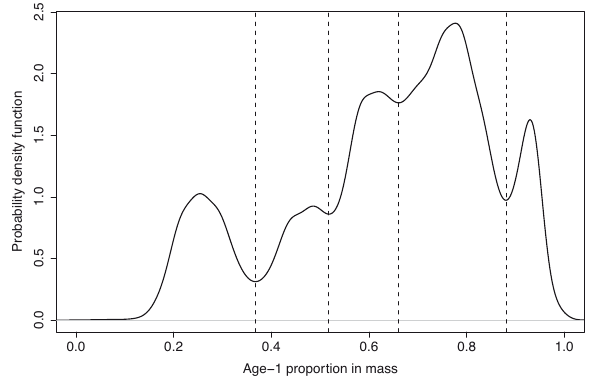
Fig . 3. – Probability density plot of the mixture distribution of the age-1 proportion in mass from 1987 to 2008 as estimated in the stock assessment model (ICES, 2008a). The vertical dashed lines define five levels of relative recruitment (very low, low, medium, high and very high) that will be used to define the categorical factor P representing the overall age-1 proportion in each factor